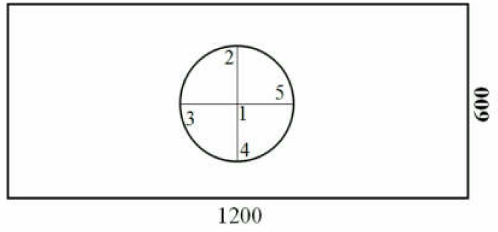
Figure 6. Displacement measuring point arrangement on the back side of the specimen.